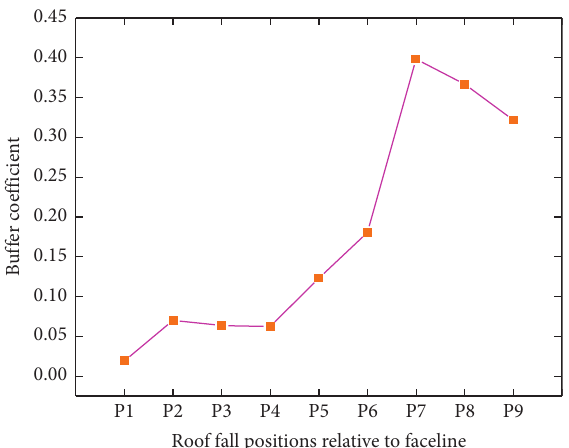
Figure 7: Distribution of buffer coefficient on shield legs at dif- ferent roof fall positions. Roof fall positions P 1 –P 9 have the same meaning with Figure